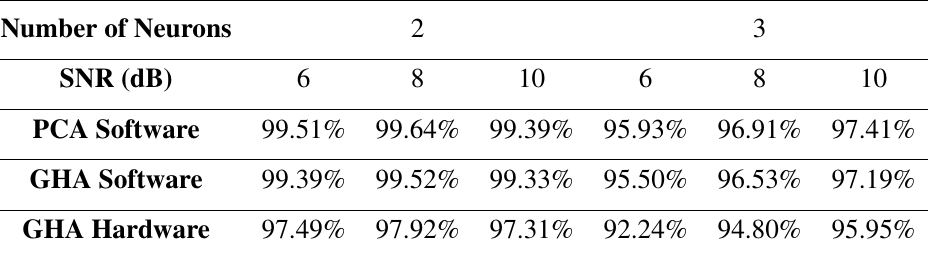
Table 10. The classification success rates (CSRs) of the feature vectors produced by the GHA and PCA hardware/software implementations for two and three